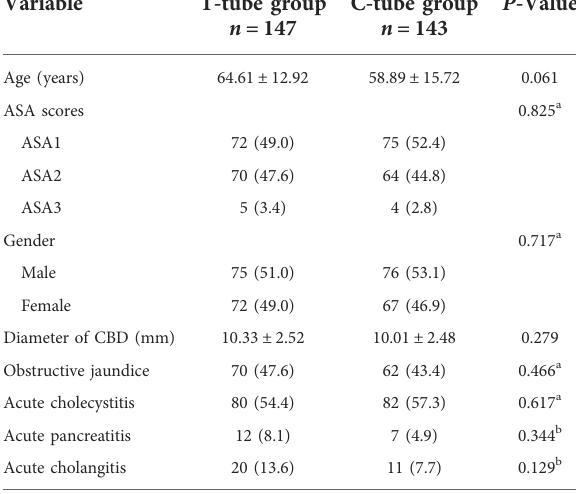
TABLE 1 Clinical characteristics of patients with LC+LCBDE in each group.